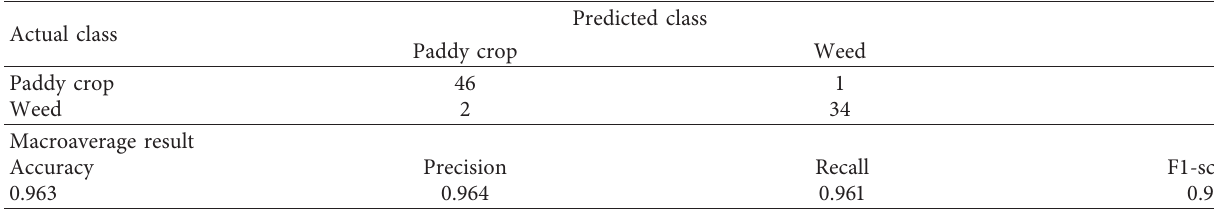
Table 9: Confusion Matrix of classification of paddy crops and weeds of the dataset by [48].